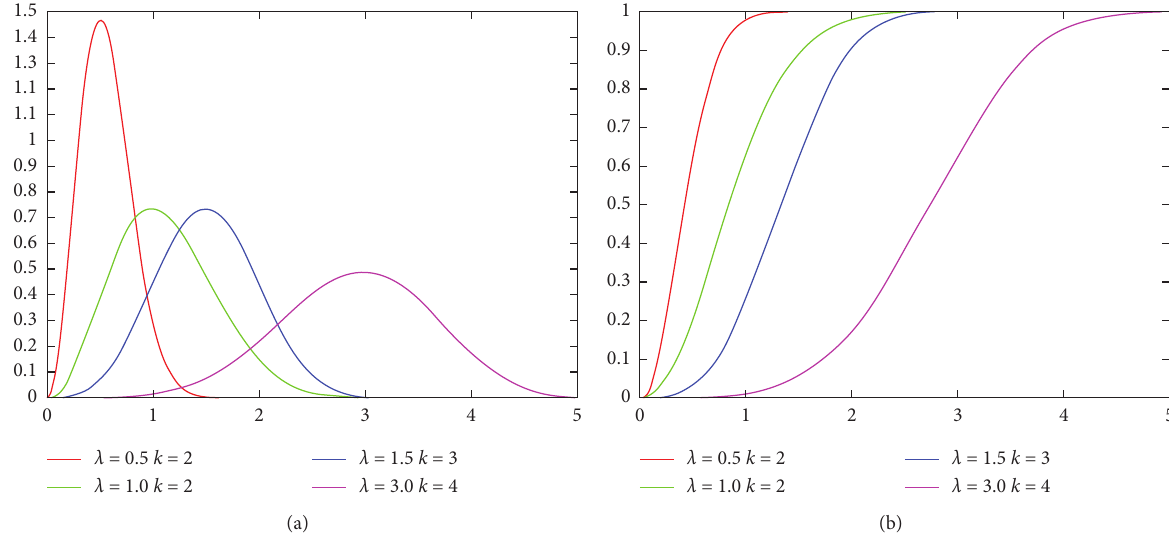
Figure 1: Density function (a) and distribution function (b) of